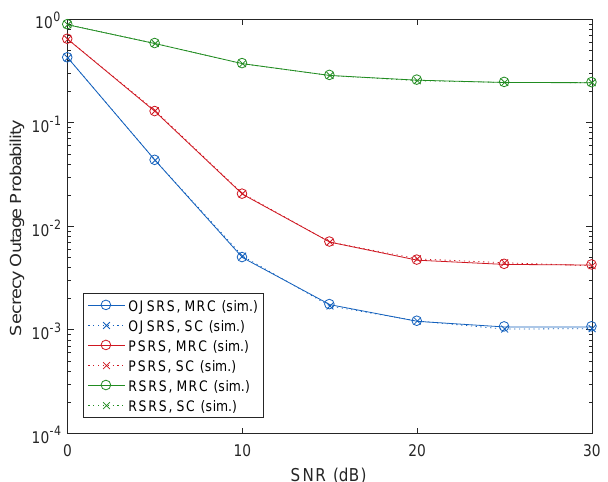
Figure 6. Performance comparison between the PSRS, OJSRS and RSRS schemes with the secrecy outage probability as a function of signal-to-noise ratio (SNR) with M = 3, N = 3, d SR = 0.5, MER = 20 dB and R th = 2 bits/s/Hz.